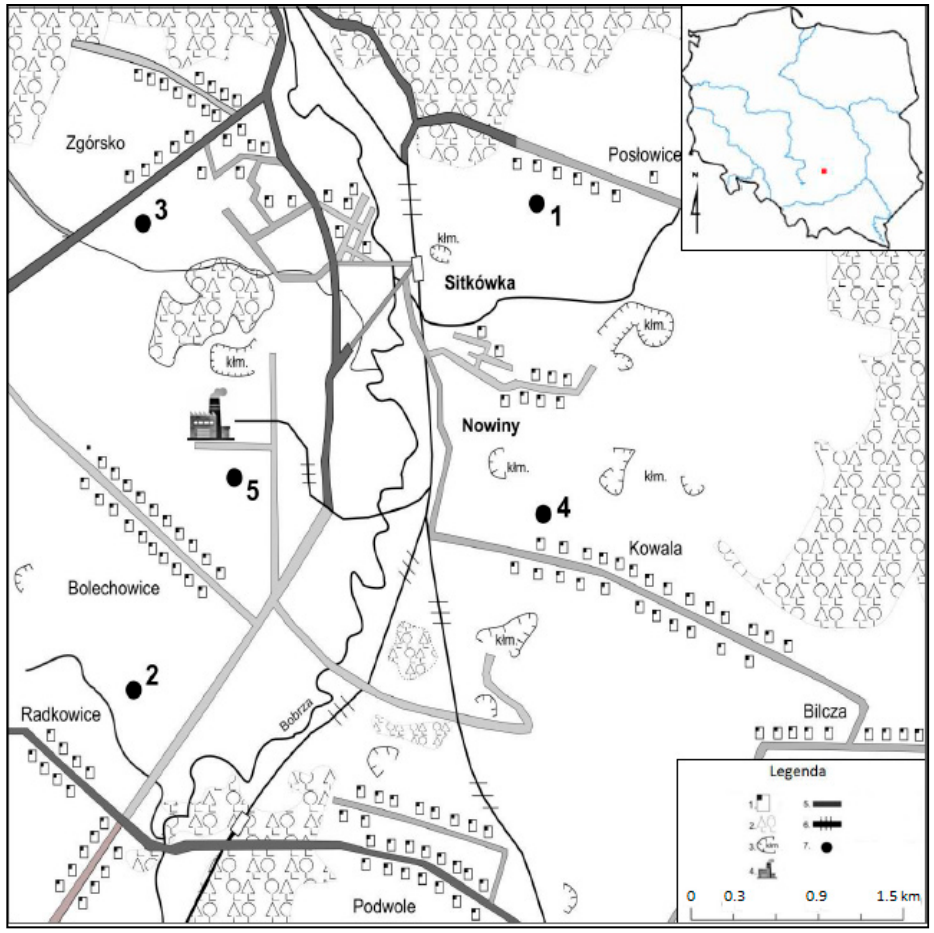
Figure 1. Location of soil pits depending on the distance from the dust emitter (Nowiny Cement Plant Sp. z o. o.). Key: (1) Buildings; (2) forests; (3) quarries; (4) cement plants; (5) roads; (6) railways; (7) soil pits.